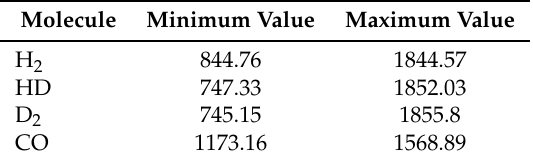
Table 1. Wavelength range (Å) of H 2 , HD, D 2 and CO consulting